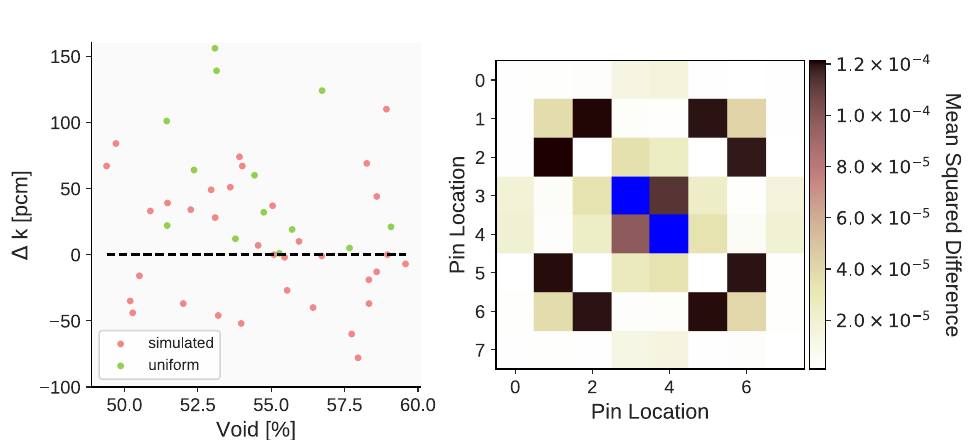
Figure 4: Comparison of experimentally-determined radial void distributions and their − k homogeneous equivalents. k (left) and mean squared difference of normalized homog hetero pin powers between homogeneous and heterogeneous cases (right).